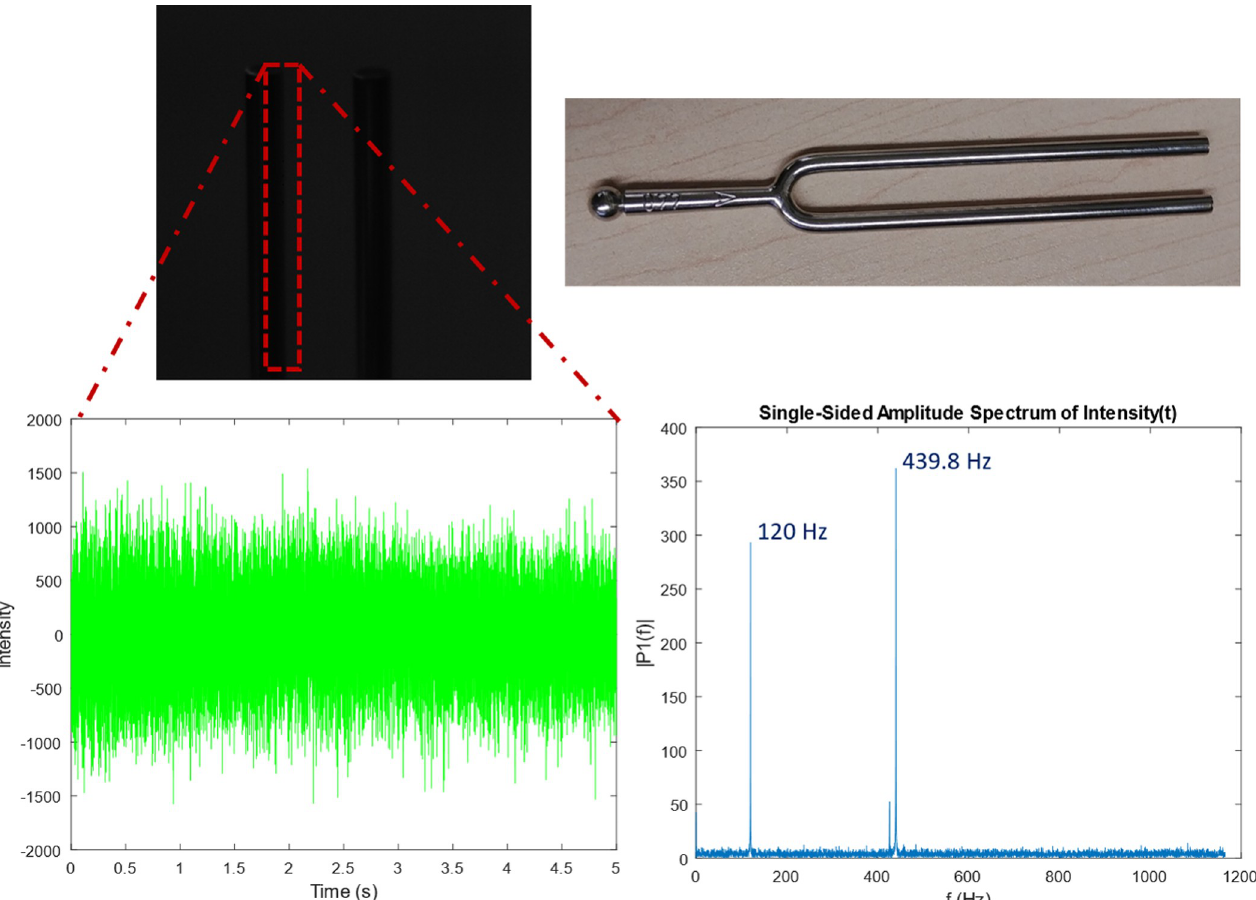
Fig 5. A 440 Hz tuning fork captured at 2329 fps using only ambient lighting. Fourier analysis identified the fork’s frequency as well as the 120 Hz flicker of the ambient fluorescent lighting.